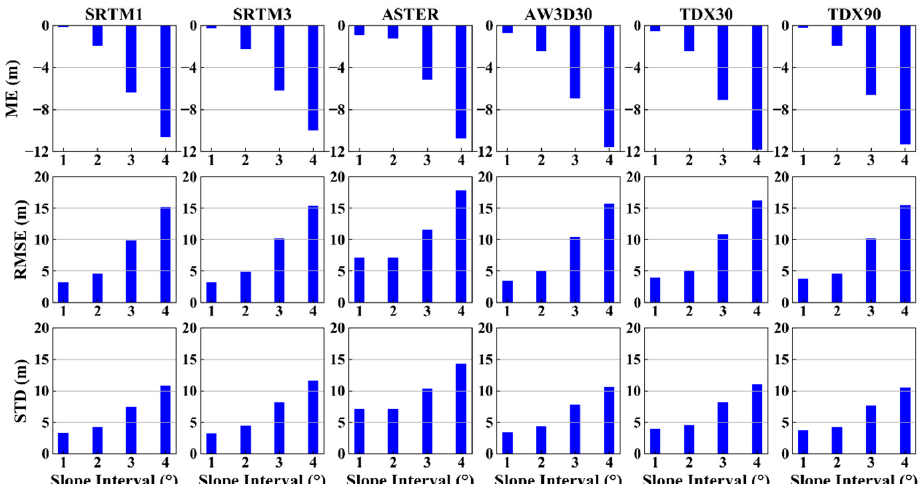
Figure 5. DEM error statistics of di ff erent slopes; ME (top), RMSE (middle) and STD (bottom). (1: 0–2 ◦ ; 2: (2–6 ◦ ]; 3: (6–25 ◦ ]; 4: > 25 ◦